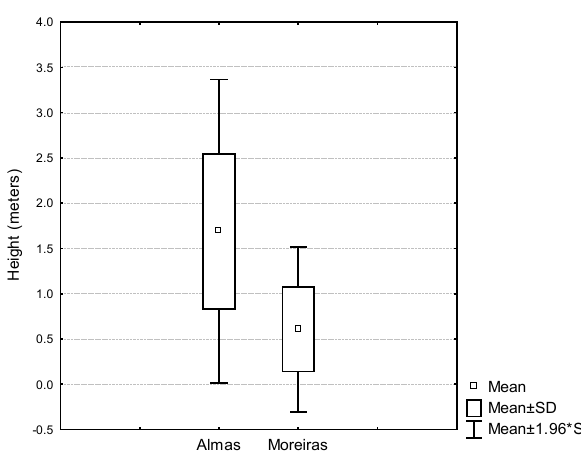
Fig 1 . Box plot showing the height (meters) of termitaria nested by Partamona seridoensis in Almas (N= 28) and Moreiras Farms (N= 21). The volume of the termite nests in which the bee colonies were hosted varied from 33.8 liters to 233 liters (mean = 98.2 ± 45.88 liters; Fig 2).